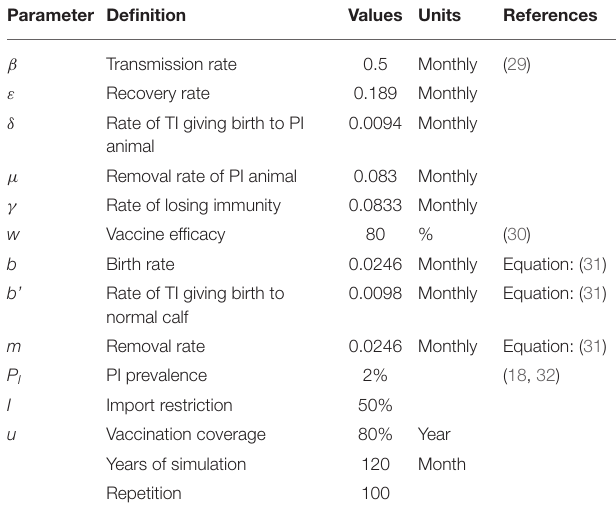
TABLE 4 | Summary of all parameter